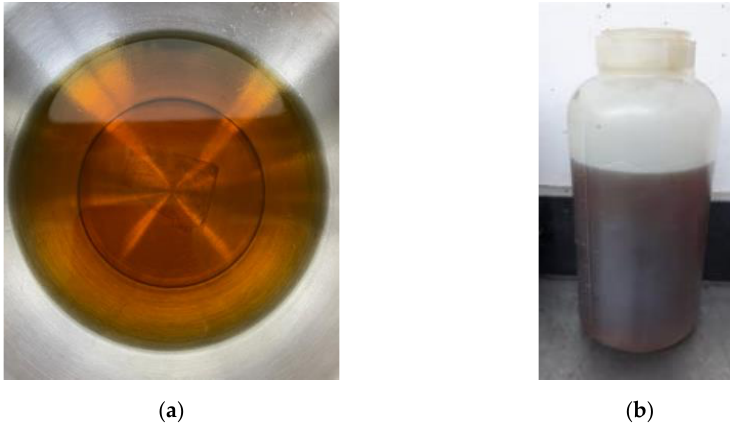
Figure 2. WMA additives: ( a ) Evotherm M1; ( b ) Iterlow T.